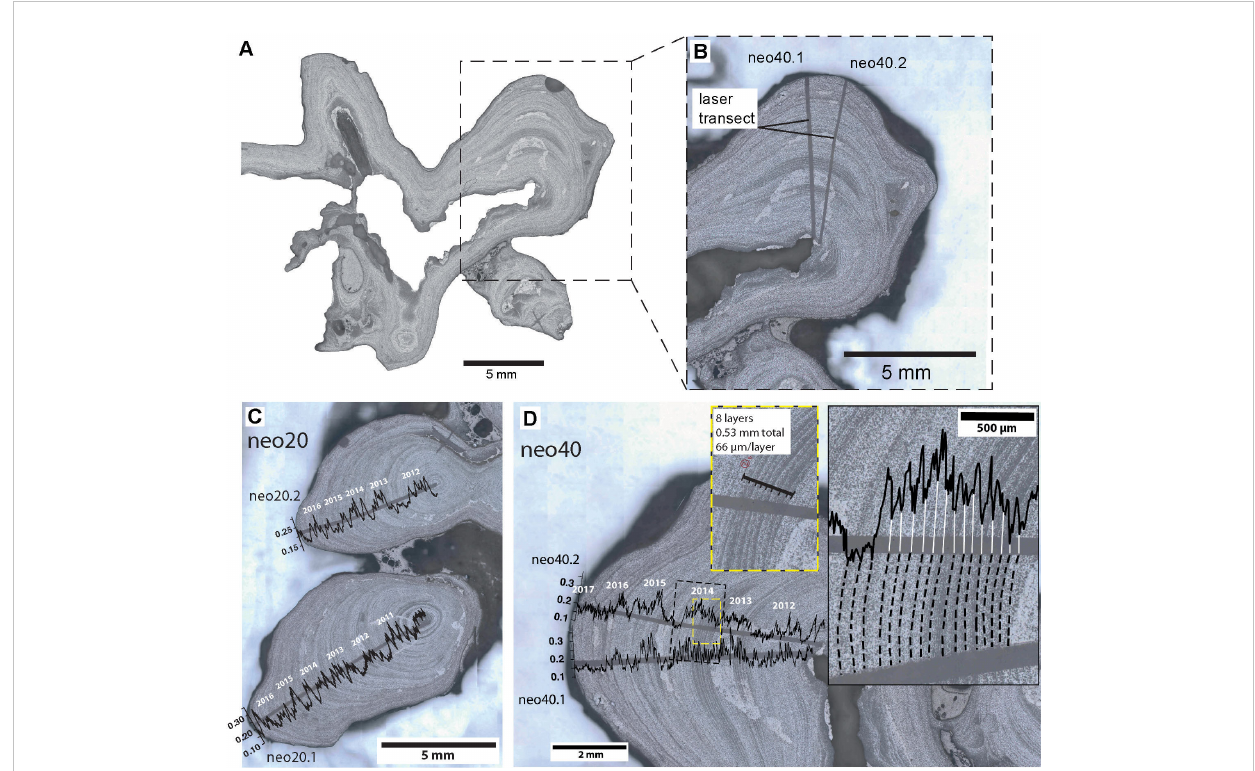
FIGURE 2 Sectioned and analyzed samples of Neogoniolithon hauckii . (A) Sectioned sample neo40, enlarged inset (B) shows longitudinal section of analyzed protuberance. (B) Magni fi cation of sectioned protuberance with measurement transects after LA-ICP-MS analysis. Samples neo20 (C) and neo40 (D) after LA-ICP-MS analysis. Mg/Ca ratios plotted over measurement transects. Approximate year markers based on Mg/Ca age model (see Supplementary Figure 2) are placed above laser transects in order to illustrate seasonal cycles. (D) Two separate transects on sample neo40. Right inset shows enlarged area marked by stippled line rectangle. Mapped subannual growth lines indicated by stippled lines. White lines link minimum values of subannual cycles in Mg/Ca ratios to mapped subannual banding. Smaller inset (yellow stippled line) shows portion of the annual band 2014 where subannual band thickness was measured directly on photomosaic (8 layers marked with black bold line, total length of 0.53 mm, 66 µm per subannual layer on average, respectively). Mg/Ca ratios in (C, D) in